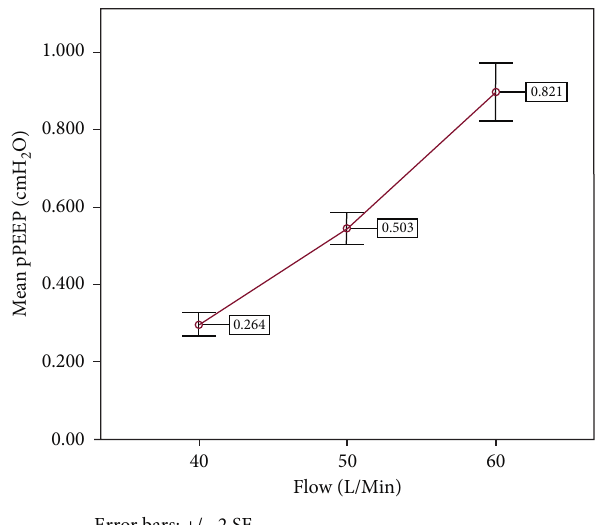
Figure 4: Mean and SE of pPEEP in cmH 2 O with 40 L/min, 50 L/min, and 60 L/min